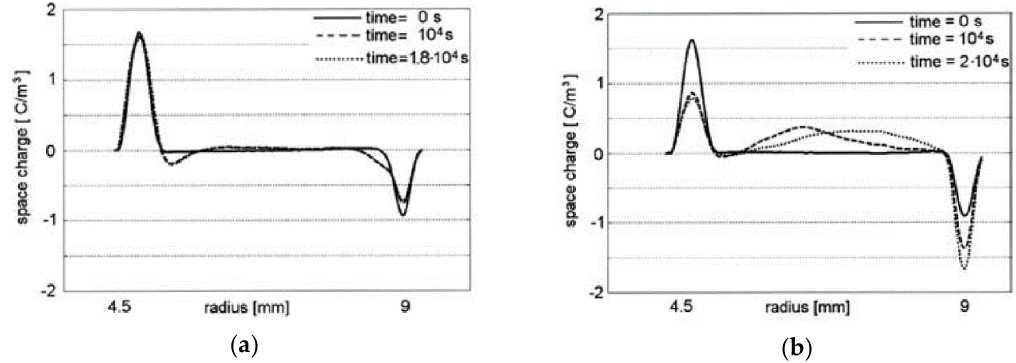
Figure 11. Space charge profiles from tests on XLPE MV-size cables with an average field of 20 kV / mm. ( a ) no temperature gradient. ( b ) with a temperature gradient of 20 ° C [5].